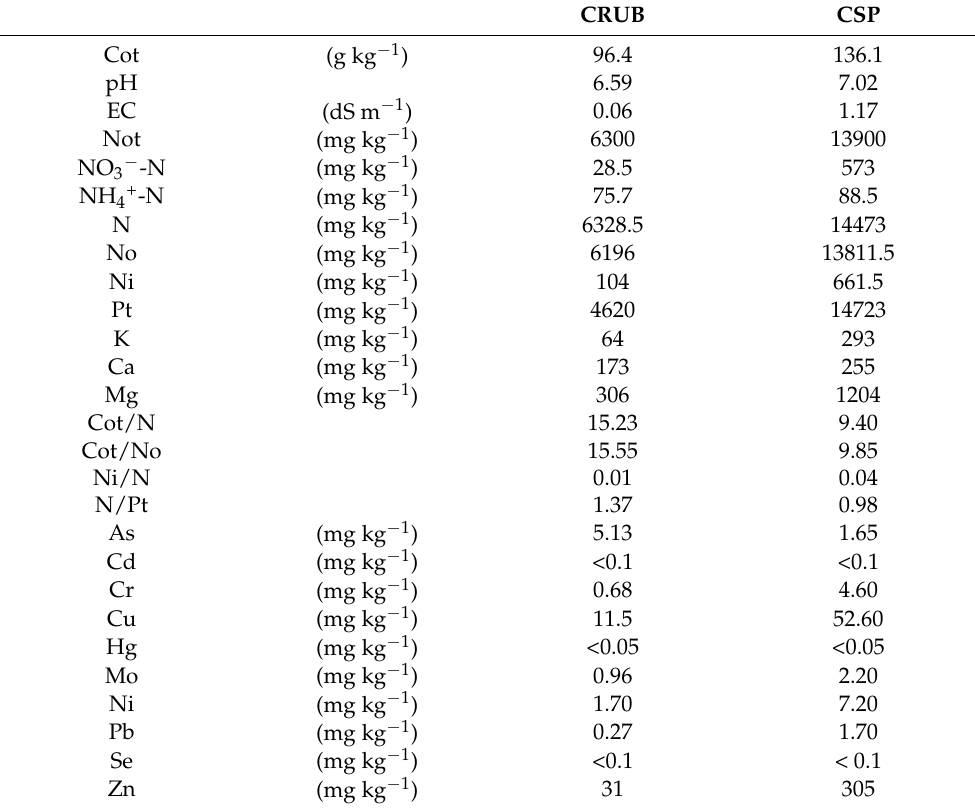
Table 2. Principal characteristics of the composts used for the mineralization